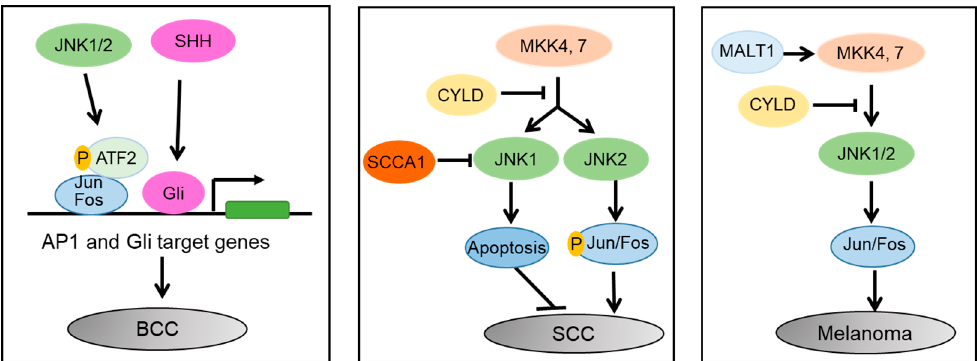
Figure 5. Differential roles of JNK1 and JNK2 in skin cancers. In BCC, JNK1/2 activates Jun/Fos, and enhances their interaction with phosphorylated ATF2, which then enhances SHH/Gli induced tumorigenesis. In SCC, MKK4/7 activates JNK1 and JNK2. JNK1 induces apoptosis, whereas JNK2 promotes carcinogenesis in an AP1-dependent manner. SCCA1 promotes SCC via inhibition of JNK1 and CYLD inhibits SCC via suppression of JNK2/AP1 cascade. In melanoma, the MALT1, MKK4/7, and JNK/AP1 signaling cascade promotes melanoma cell proliferation and migration, whereas CYLD inhibits it.